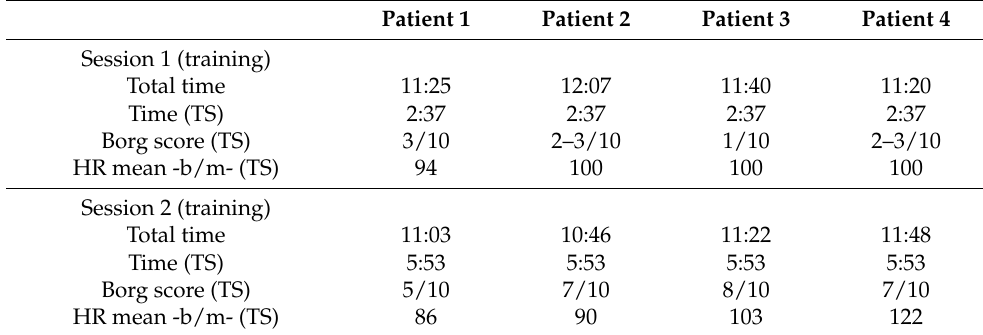
Table 3. Effort scores (perceived exertion and heart rate) for each session.